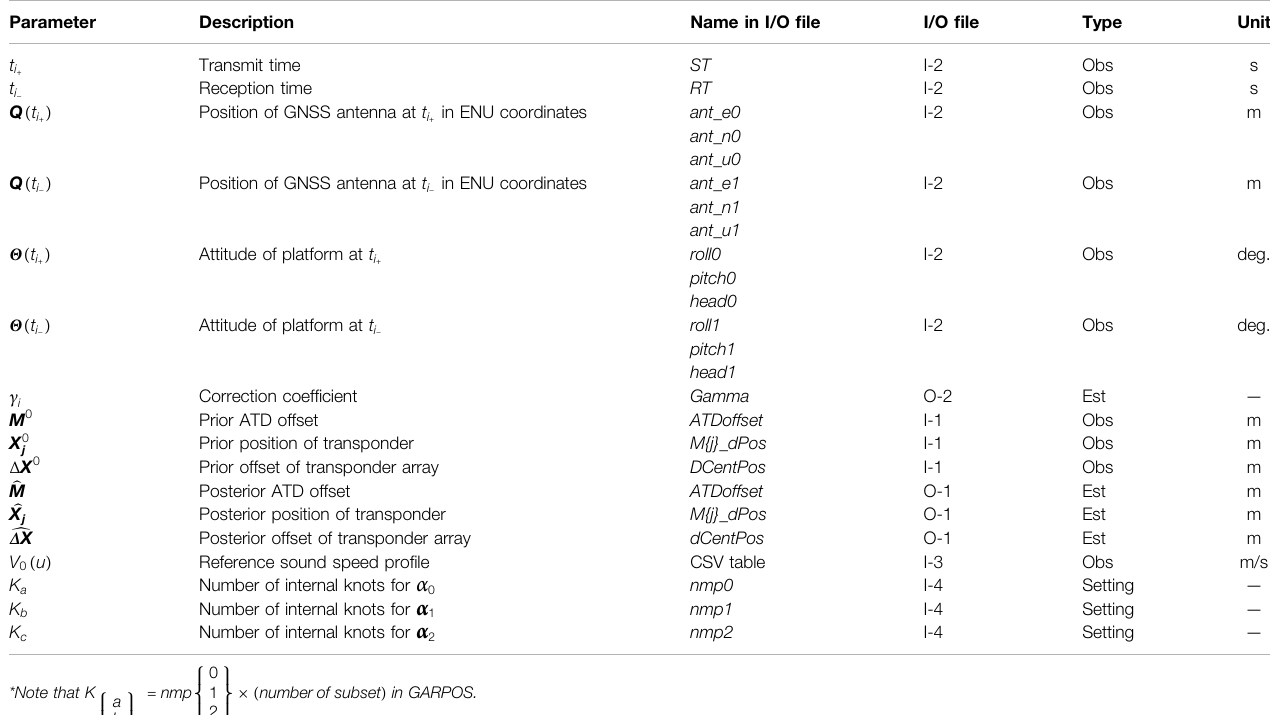
TABLE 1 | List of observable and estimation parameters used in GARPOS. Parameter